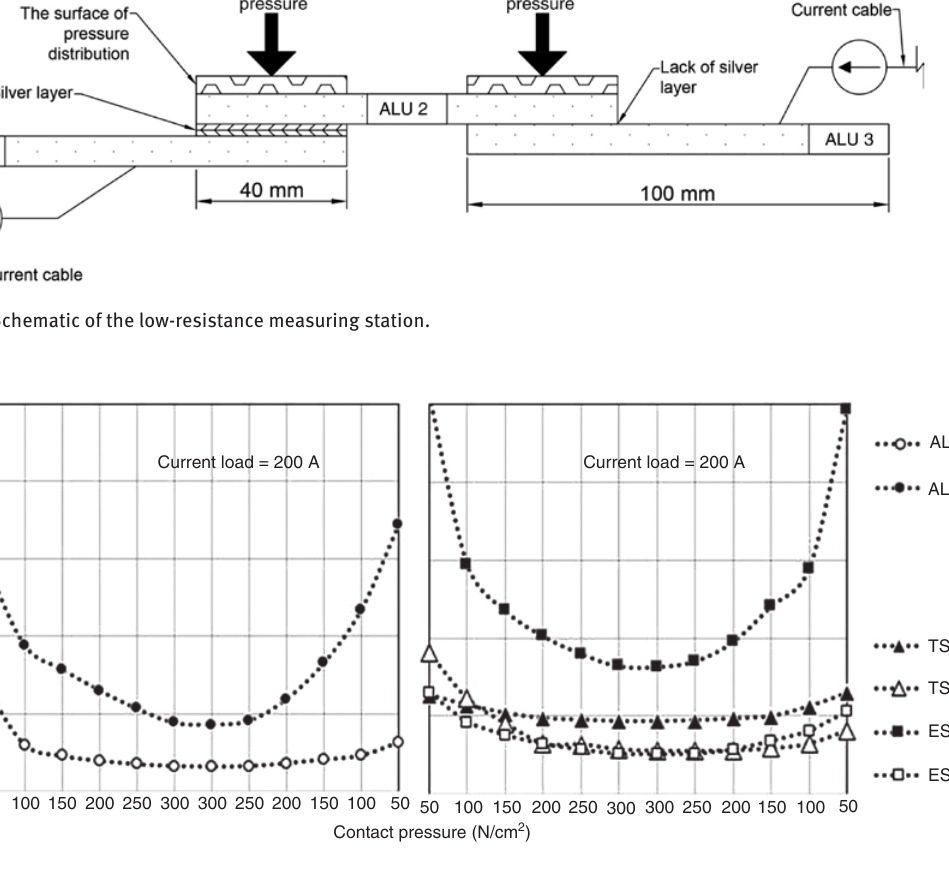
Figure 5: Paint SilverCon – current of 200 A (AL1: cleaned AL-AL and AL2-AL-AL after 7 days, TS1: thermal silver-plated Al interface, TS2: thermal silver-plated Al with petrolatum, ES1: electro silver-plated Al interface, ES2: electro silver-plated Al interface with